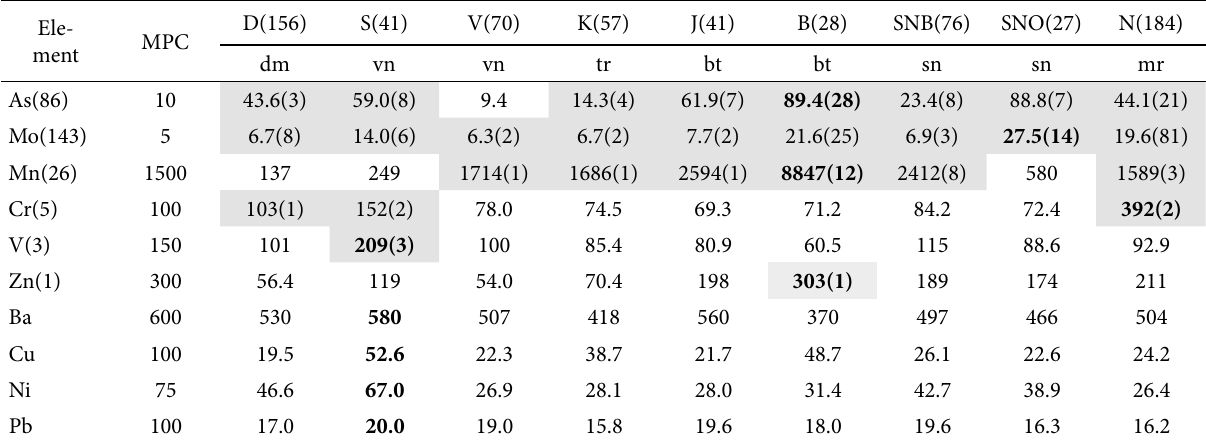
Table 1. Maximum content of harmful chemical elements (mg/kg) in sections of interglacial sediments compared with soil maximum permitted concentrations (mg/kg)